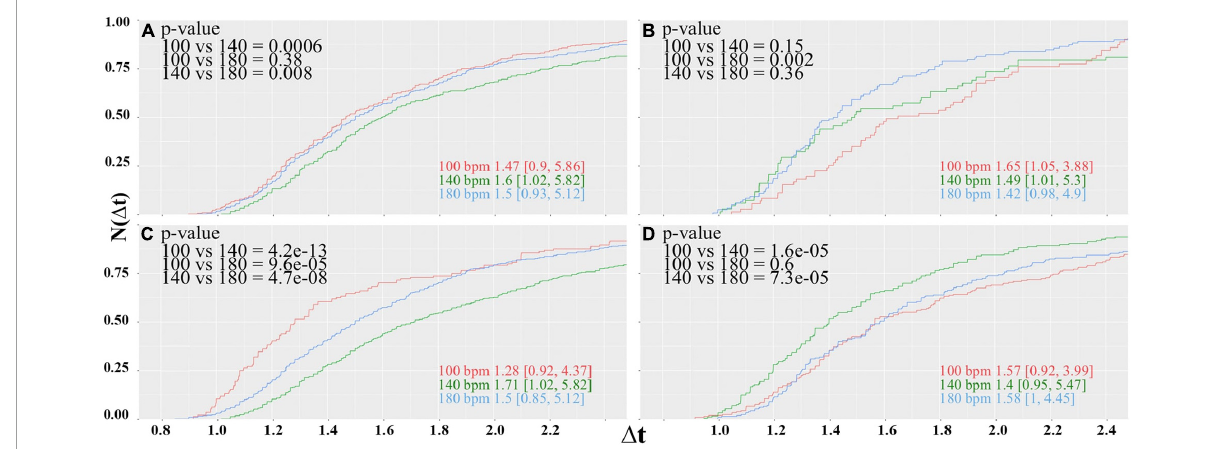
FIGURE5 Same as Figure, but now the female subjects are divided according to the actual phase of their menstrual cycle. Cumulative distributions of reaction times of the female participants in the (A) menstrual, (B) folicular (C) ovulatory and (D) luteal phase